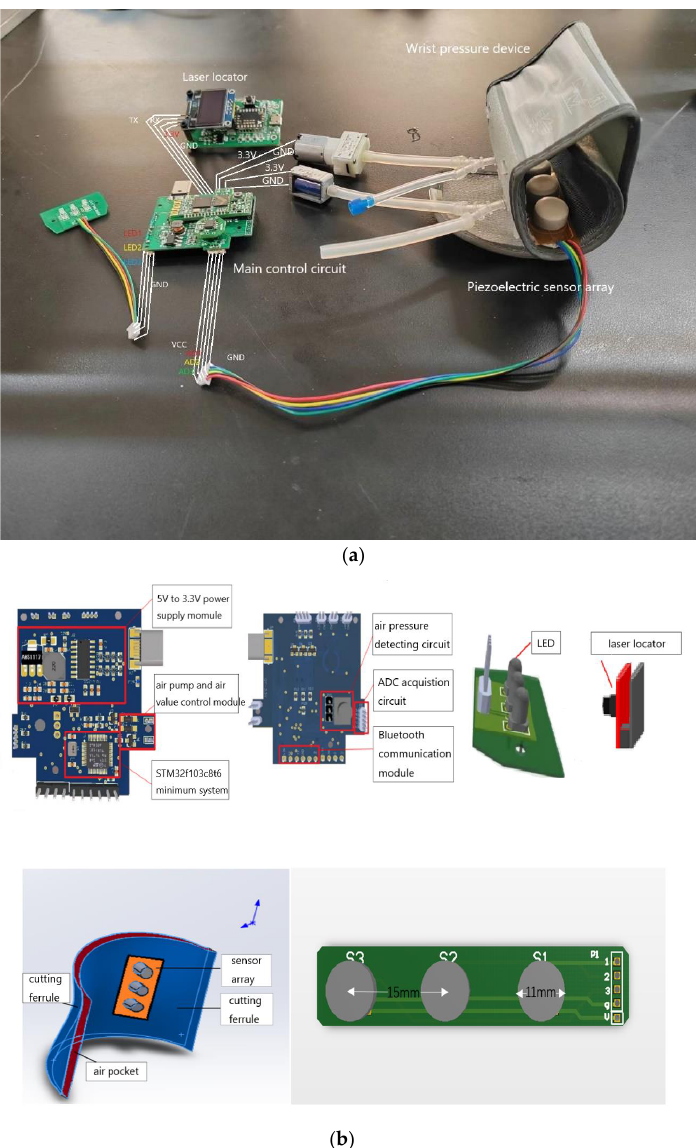
Figure 1. System constituents: ( a ) physical hardware; and ( b ) description of circuits.